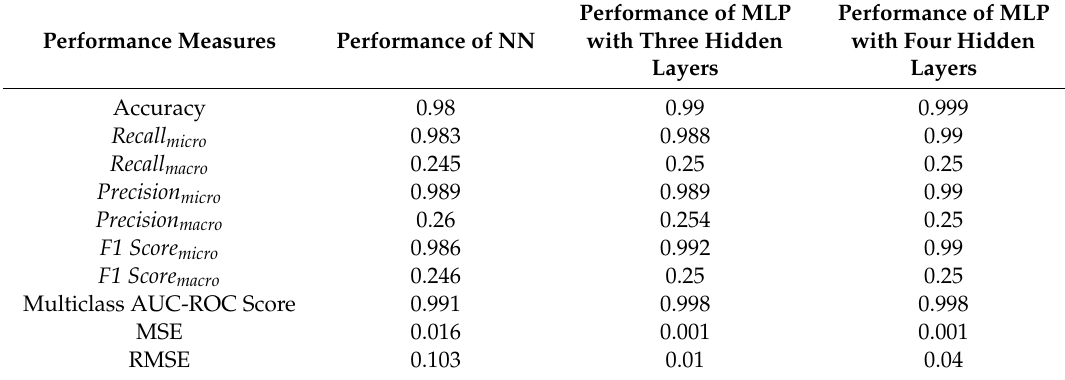
Table 5. Performance of NN and MLP with N h = 50 for multiclass classification averaged over ten independent runs.